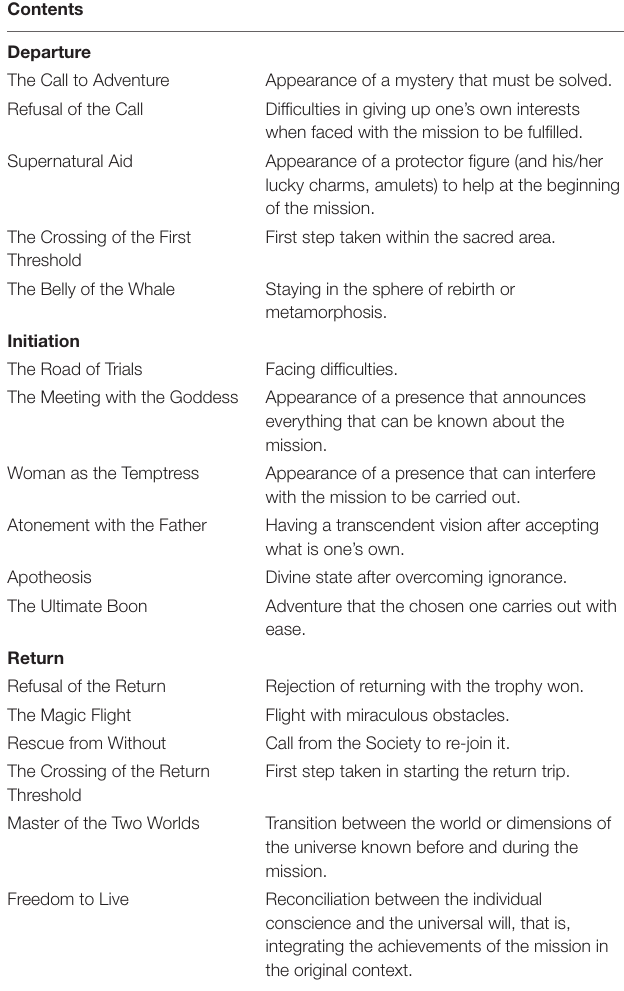
TABLE 1 | Contents of the hero/heroine story (based on Campbell,